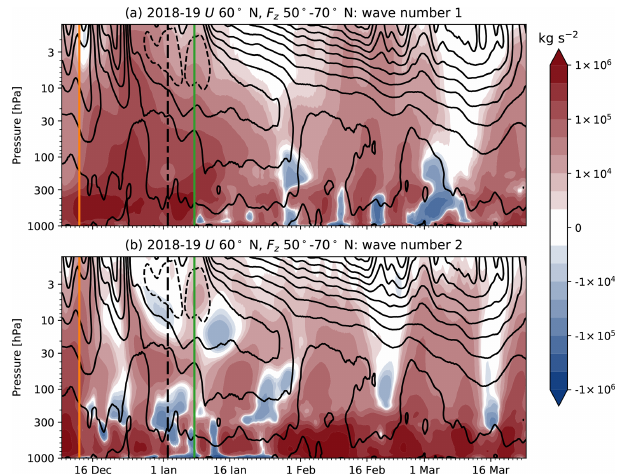
Figure 8. Wave forcing during the January 2019 boreal major warming (quantities the same as Fig. 6). The vertical dashed–dotted black line indicates the date of the wind reversal at 10hPa, 60 ◦ N. The vertical green and orange lines indicate the requested initializa- tion